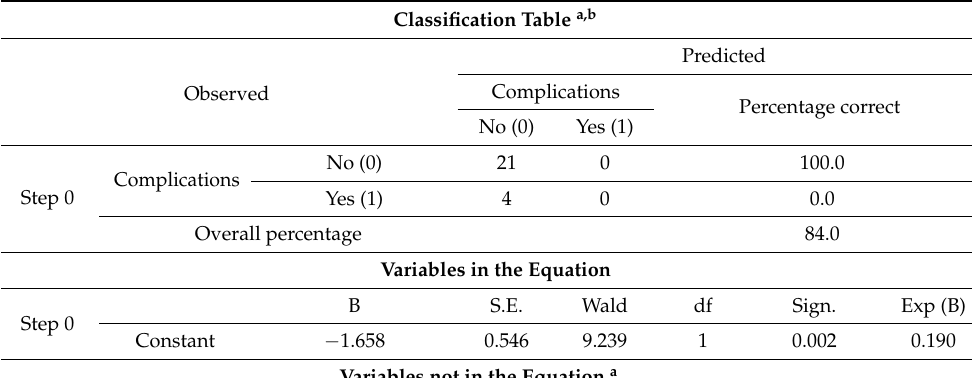
Table 10. Logistic binary regression